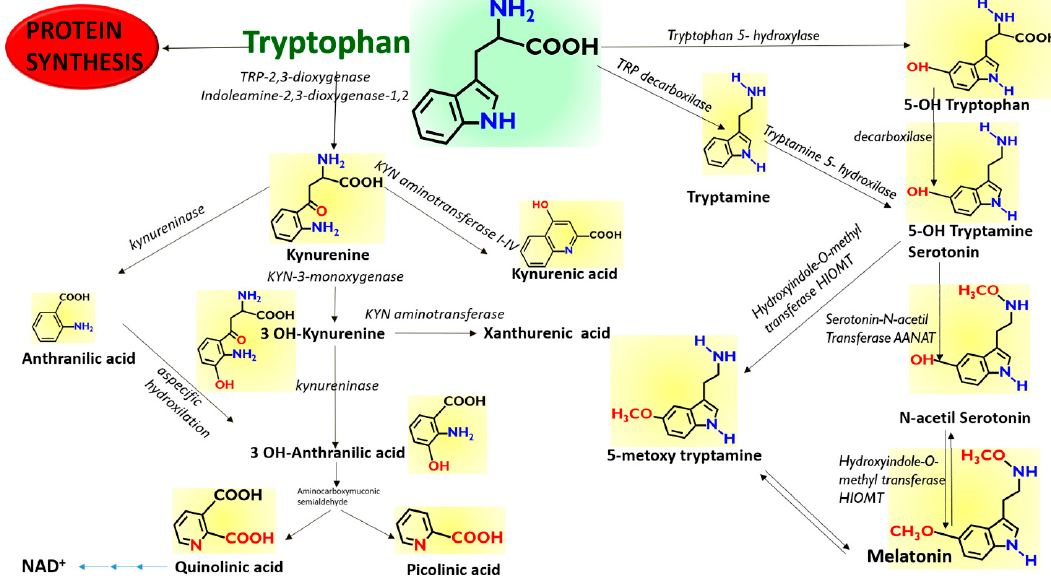
Figure 1. Scheme of the proposed pathways of Tryptophan. Tryptophan can be metabolized along the Kynurenine pathway along three different branches to Anthranilic acid, 3-OH Kynurenine, and Kynurenic acid, depending to the enzymatic repertoire of the cells. Tryptophan can also be metabolized along the Melatonin pathway through the synthesis of 5-OH Tryptamine (Serotonin) and by using preferentially different enzymes depending on the cellular repertoire.